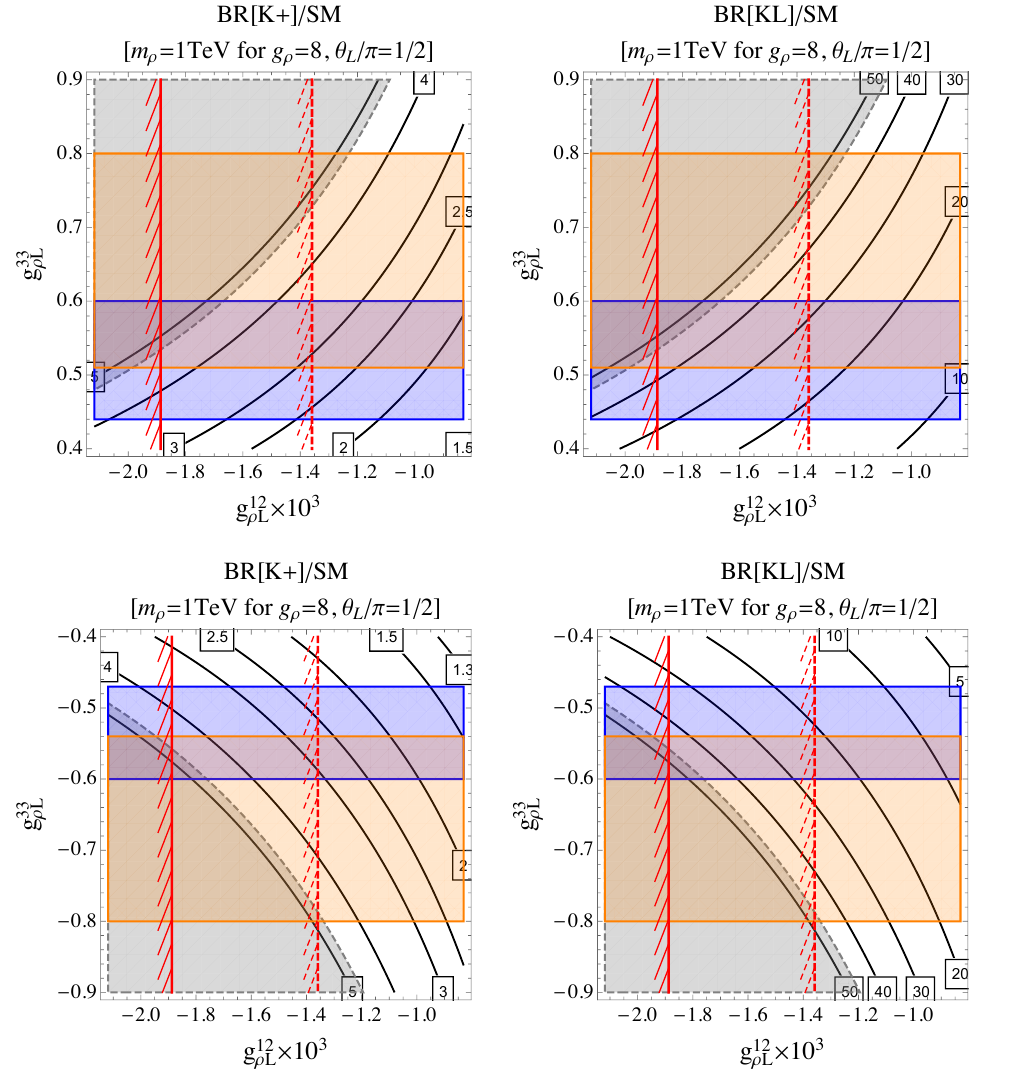
Figure 7 . The plots of the predicted curves for the Br[ K + ! (cid:25) + (cid:23) (cid:22) (cid:23) ] (top- and bottom-left panels) and Br[ K L ! (cid:25) 0 (cid:23) (cid:22) (cid:23) ] (top- and bottom-right panels), normalized to the SM values, in the ( g 12 plane with m (cid:26) = 1 TeV, g (cid:26) = 8 and (cid:18) L = (cid:25)= 2 fixed. The numbers attached on the curves denote the values of evaluated branching ratios over the SM predictions. The plotted ranges for g 12 have been zoomed in on a viable parameter space extracted from figure 6, which fully satisfies the (cid:1) M K bound and are separated into two, depending on the sign of g 33 panels for positive and negative cases, respectively). The two red-vertical lines in each panel depict boundaries set by the 1 (cid:27) (solid) and 1 : 5 (cid:27) (dashed) ranges allowed by the (cid:15) 0 =(cid:15) constraint. The parameter spaces inside the blue and orange regions enable us to address the R (cid:18) D =(cid:25) = 2 : 0 (cid:2) 10 (cid:0) 3 and 1 : 5 (cid:2) 10 (cid:0) 3 , respectively. The shaded regions colored in gray have already been excluded by the current bound on Br [ K + ! (cid:25) + (cid:23) (cid:22) (cid:23) ] at the 2 (cid:27) level [see eq. (3.55)]. We skipped to depict the 95% C.L. intervals drawn by x SM = +1% and +0 : 1% shown in figure 6 (where a large uncertainty exists in the choice of x SM